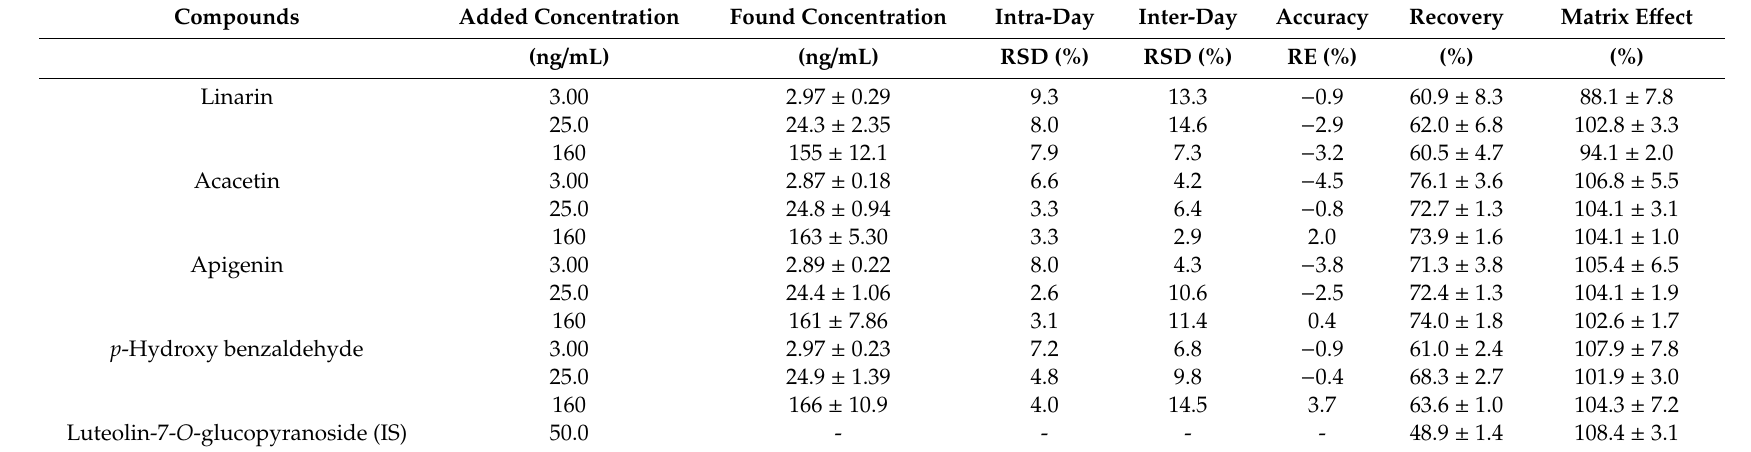
Table 3. Intra-day / inter-day accuracy, precision, extraction recovery, and matrix e ff ects of linarin, acacetin, apigenin, and p -hydroxy benzaldehyde in rat plasma. Compounds Added Concentration Found Concentration Intra-Day